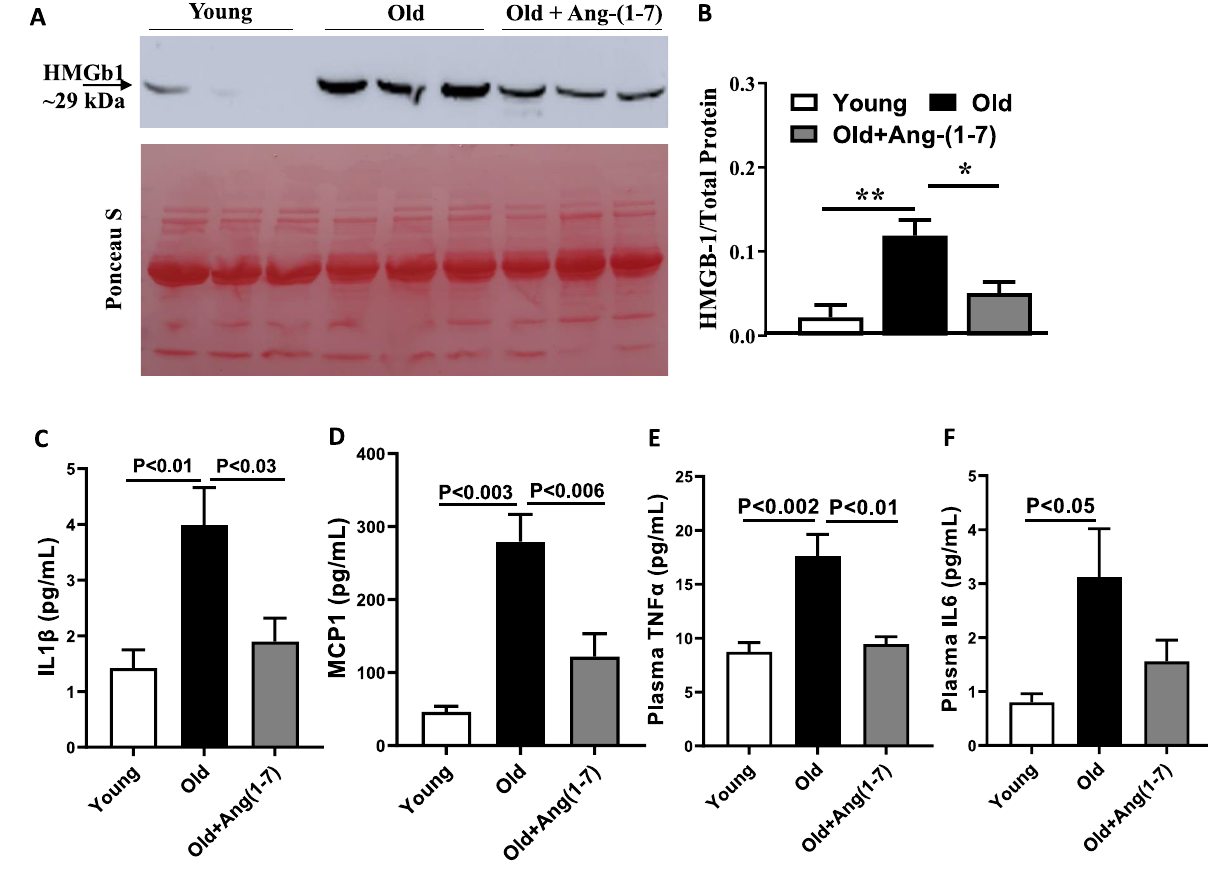
Figure 7. Ang-(1–7) decreased the concentrations of circulating inflammatory factors in the aging mice. ( A ) Representative western blots of HMGB1 levels in the plasma samples of Young, Old and Ang-(1–7)-treated Old mice. Ponceau S was used for the estimation of total protein. ( C – F ) Old mice have higher levels of HMGB1 in the circulation (**P < 0.01, n = 6) that were decreased by Ang-(1–7) (*P < 0.05, n = 6). IL1β, MCP1, TNFα and IL6 levels were higher in the plasma samples of Old mice compared to the Young. With exception of IL6, Ang-(1–7) decreased the levels of pro-inflammatory factors in the Old mice (n =